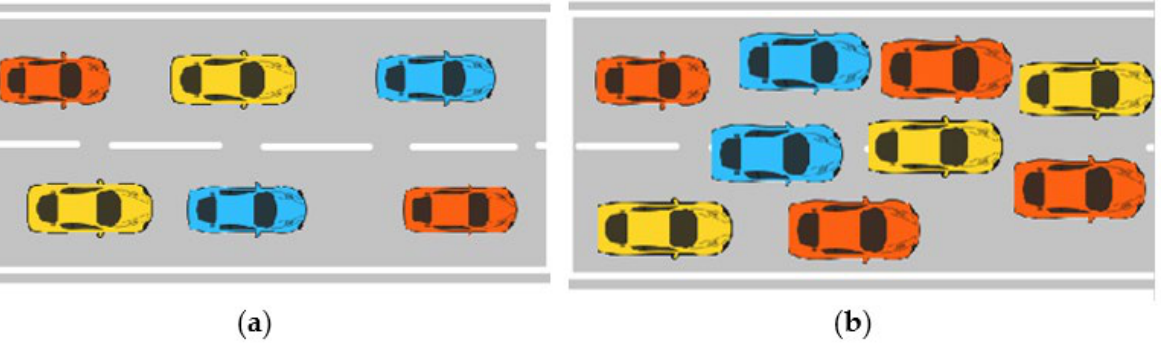
Figure 1. ( a ) Lane-based homogenous traffic. ( b ) Non-lane-based heterogeneous traffic with gap- filling behavior.